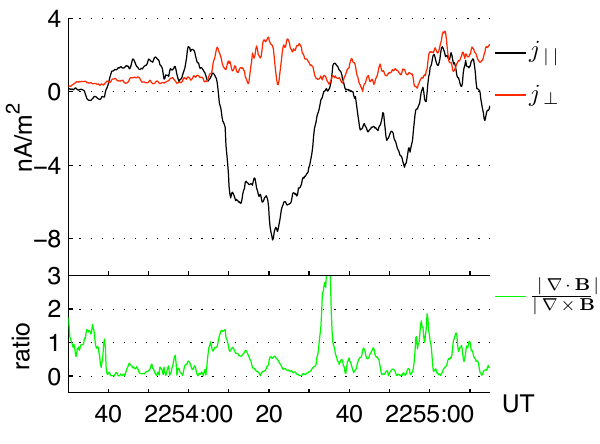
Fig. 4. Current density from the curlometer method. Top panel: j || (black line) and j ⊥ (red line). Bottom panel: The ratio |∇· B | / |∇× B | , which is an indicator of the quality of the current estimation. The interval shown is the same as the interval used for the GS reconstruction. A strong field aligned current is observed in the interval 22:54:05–22:54:35